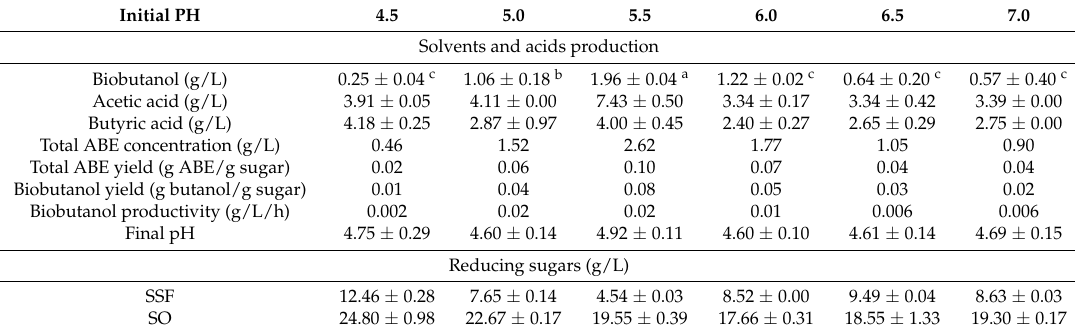
Table 2. Effect of initial pH (4.5–7.0) on biobutanol production at 35 ◦ C, cellulase loading of 15 FPU/g-substrate and 5% ( w / v ) substrate on simultaneous saccharification and fermentation by Clostridium acetobutylicum ATCC